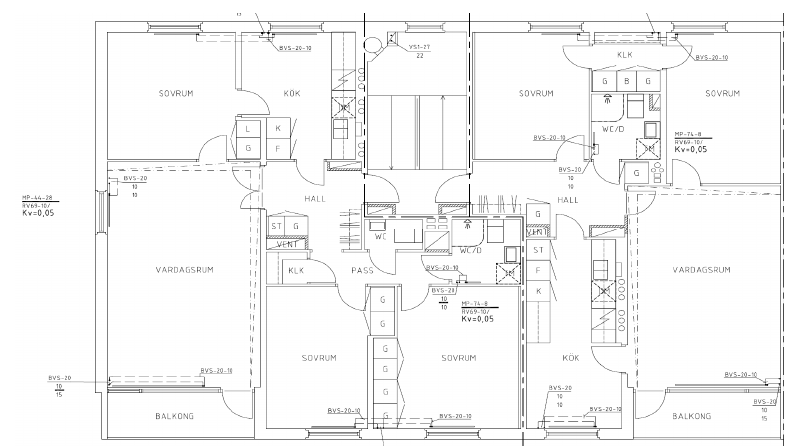
Figure 4. Floor plan of the case ‐ study building.